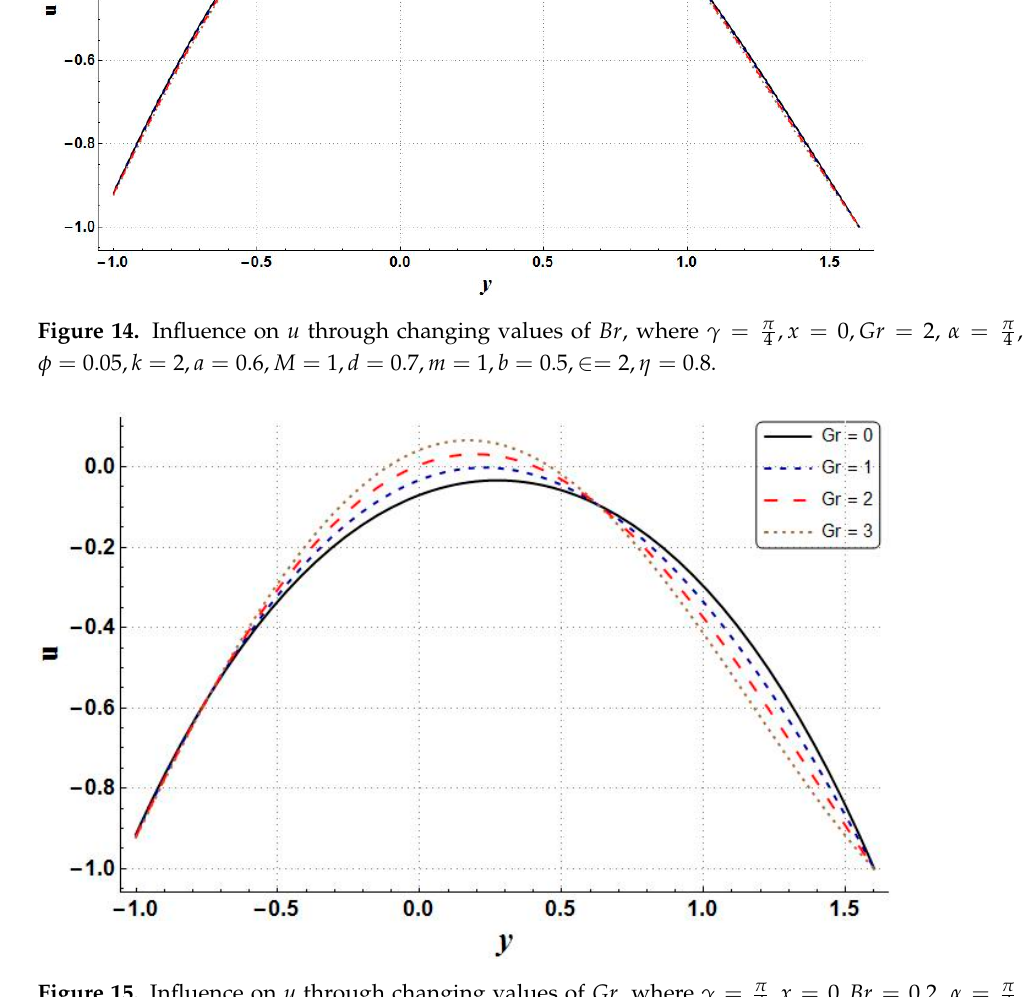
, x = 0, Br = 0.2, α = π 4 Gr , where